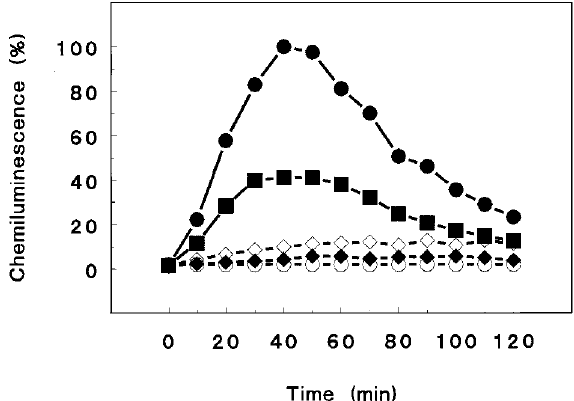
FIG. 1. Generation of chemiluminescence by isolated guinea- pig two ring tracheal preparations without stimulation ( s ), after stimulation with zymosan ( d ) or PMA ( e ) and after stimulation with zymosan ( j ) and PMA ( r ) in the presence of SOD.